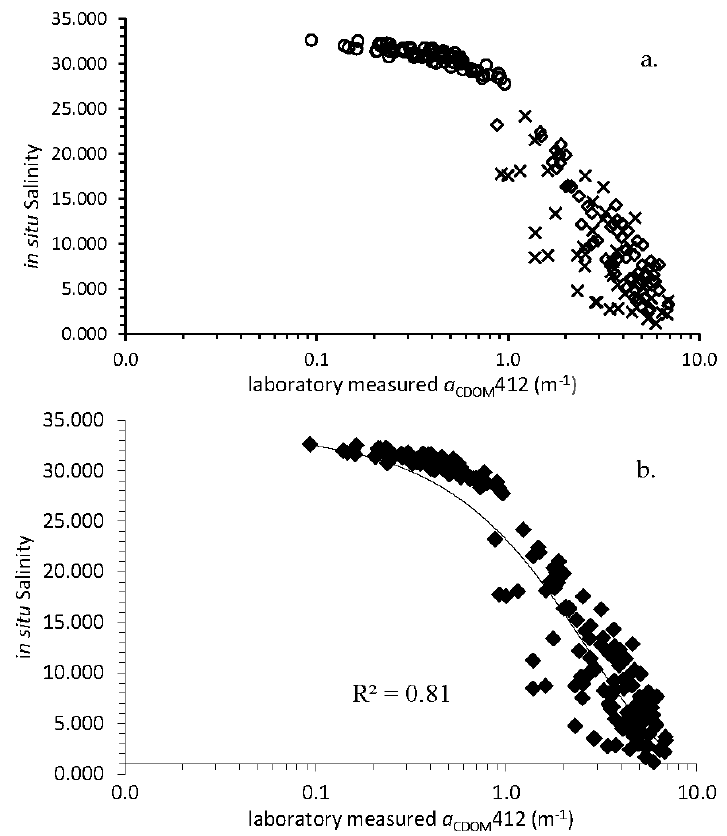
Figure 6. ( a ) Logarithmic scatterplot showing the relationship between a CDOM 412 and surface salinity measured values from stations ( n = 183) in NB ( ○ ), NR ( ◊ ), and PB (x); ( b ) Exponential trendline derived from a CDOM 412 and surface salinities for NB, NR, and PB.